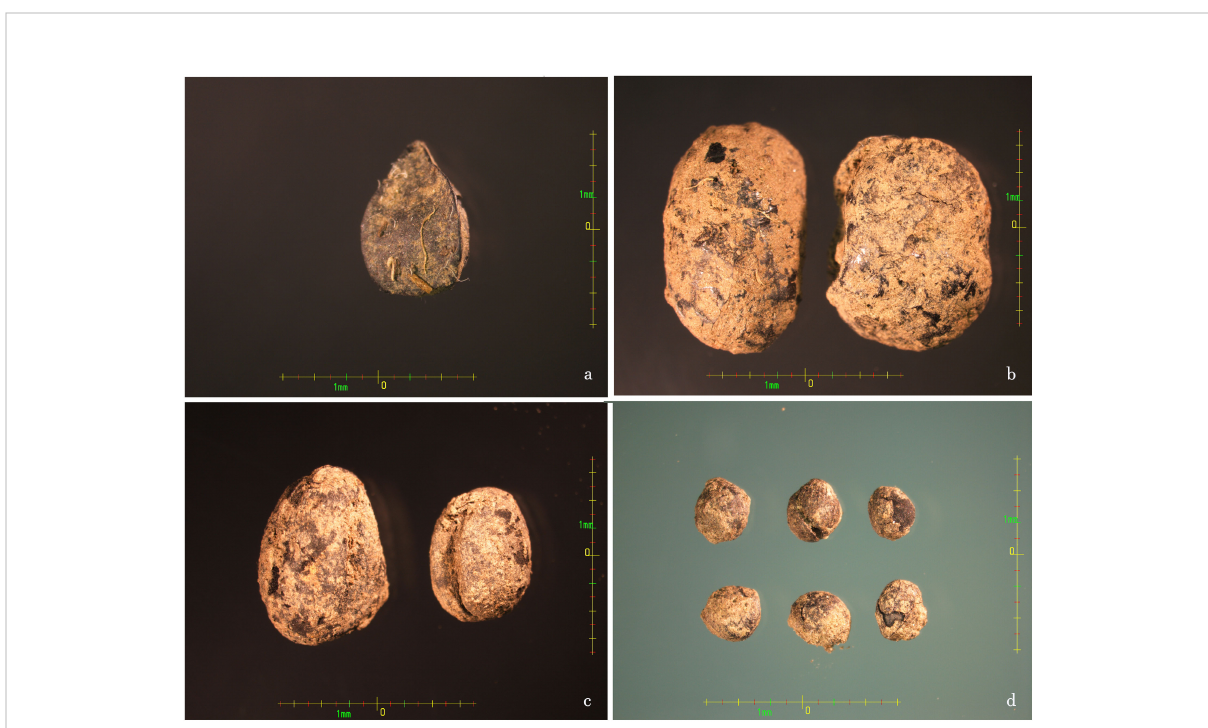
FIGURE 4 Images of LMC site plant seeds remain unearthed in part. (A) Charred buckwheat seeds; (B) Charred soybean seeds; (C) Charred cowpea seeds; (D) Charred perilla